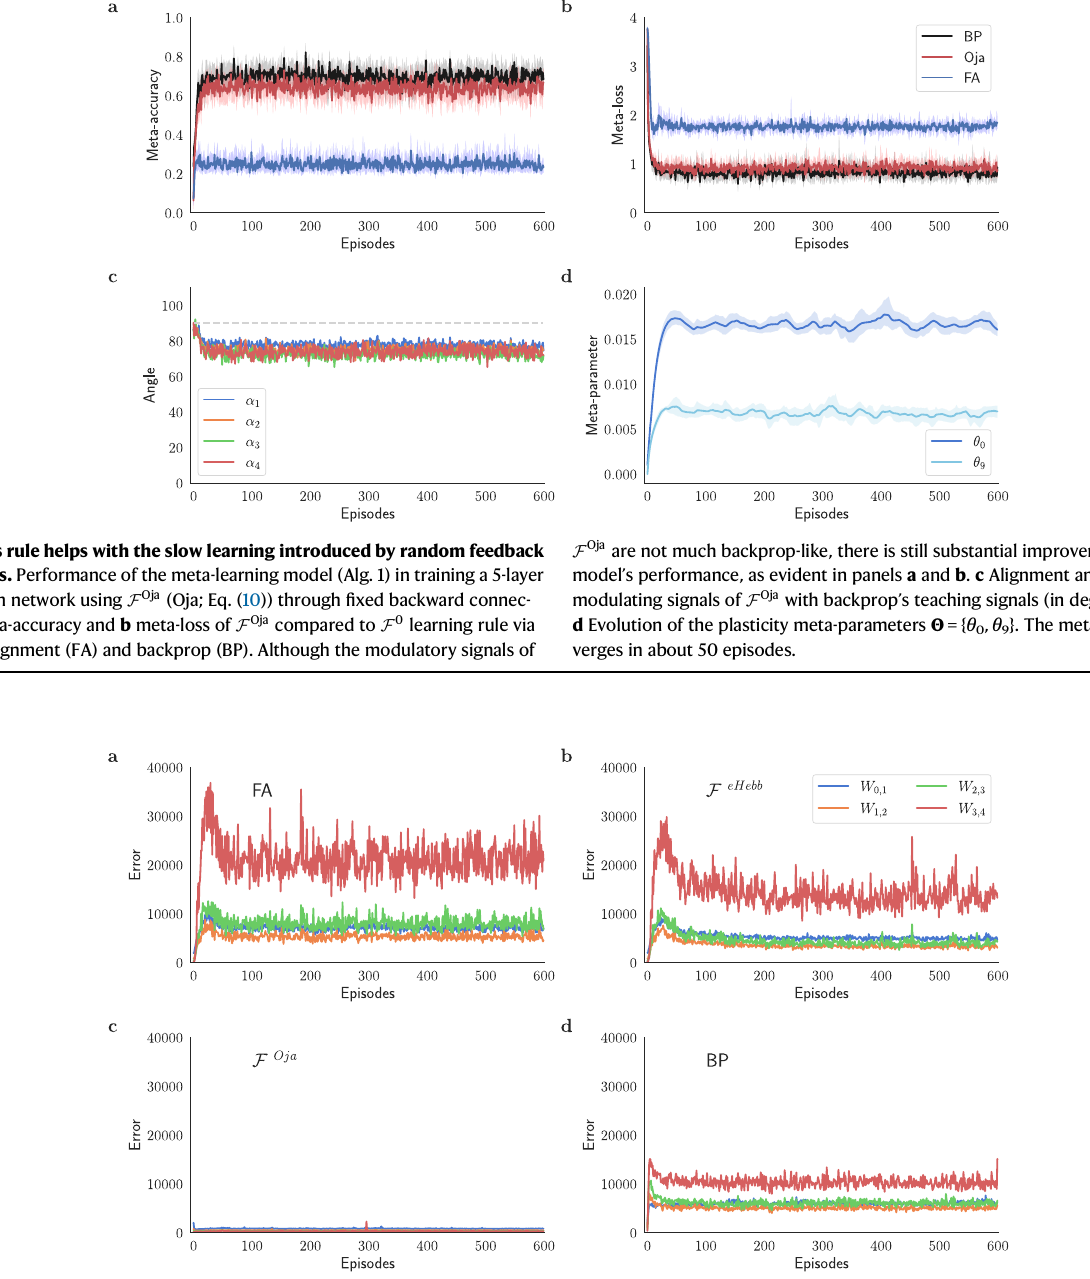
Fig. 8 | Oja ’ s rule substantially improves the orthonormality of the weight matrices. Orthonormalityerror E W (Eq.(11))computedfordifferentplasticityrules. The error is measured at the end of each meta-optimization loop (episode) for different layers of a 5-layer deep network. The model is trained using a F 0 via feedbackalignment(FA), b F eHebb , c F Oja ,and d backprop(BP).Resultsfrompanel